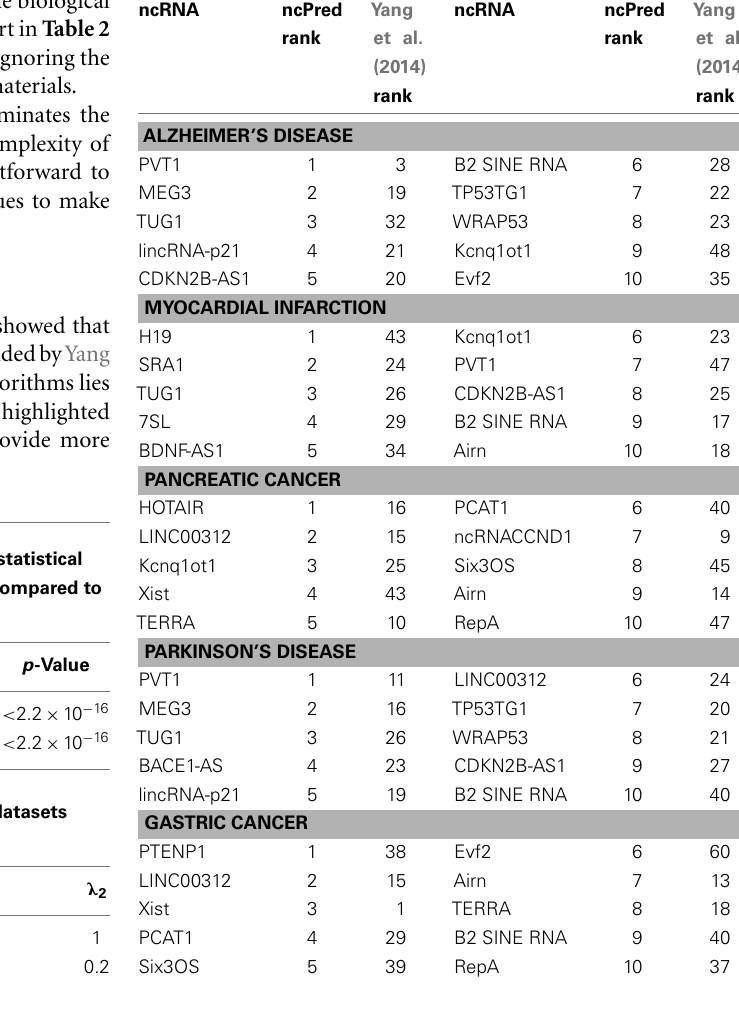
obtained withYang et al. (2014) for five case studies (Alzheimer’s Disease, Myocardial Infarction, Pancreatic Cancer, Parkinson’s Disease, and Gastric Cancer)